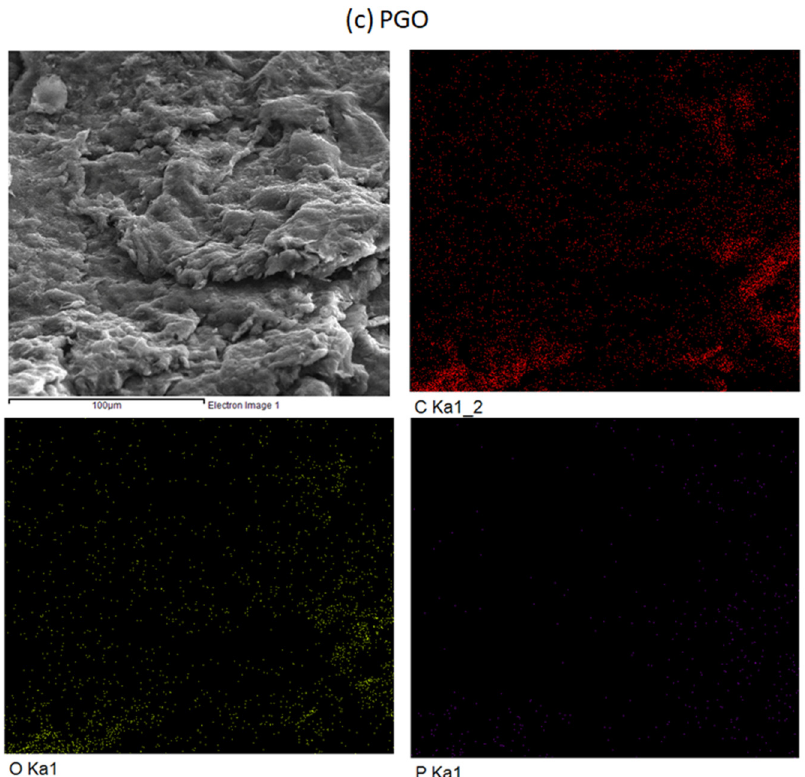
Figure 3. Field emission scanning electron microscopy (FESEM)images and energy dispersive X-ray spectroscopy (EDX) mapping of fillers ( a ) graphene oxide (GO), ( b ) sulfonated graphene oxide (SGO), and ( c ) phosphonated graphene oxide (PGO).